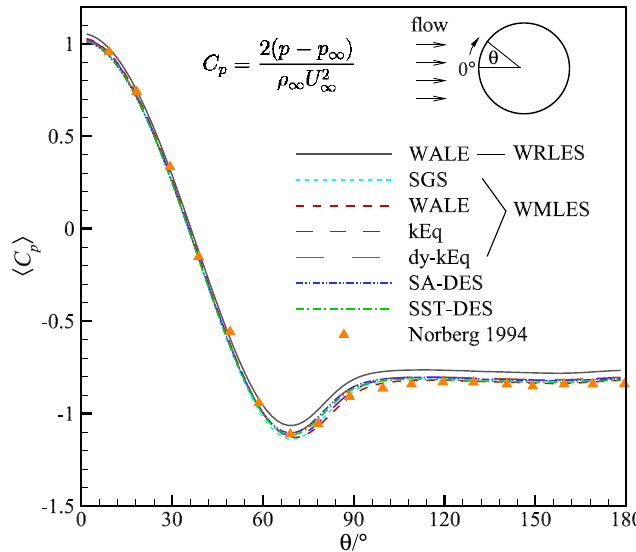
Figure 6. Mean pressure distribution on the